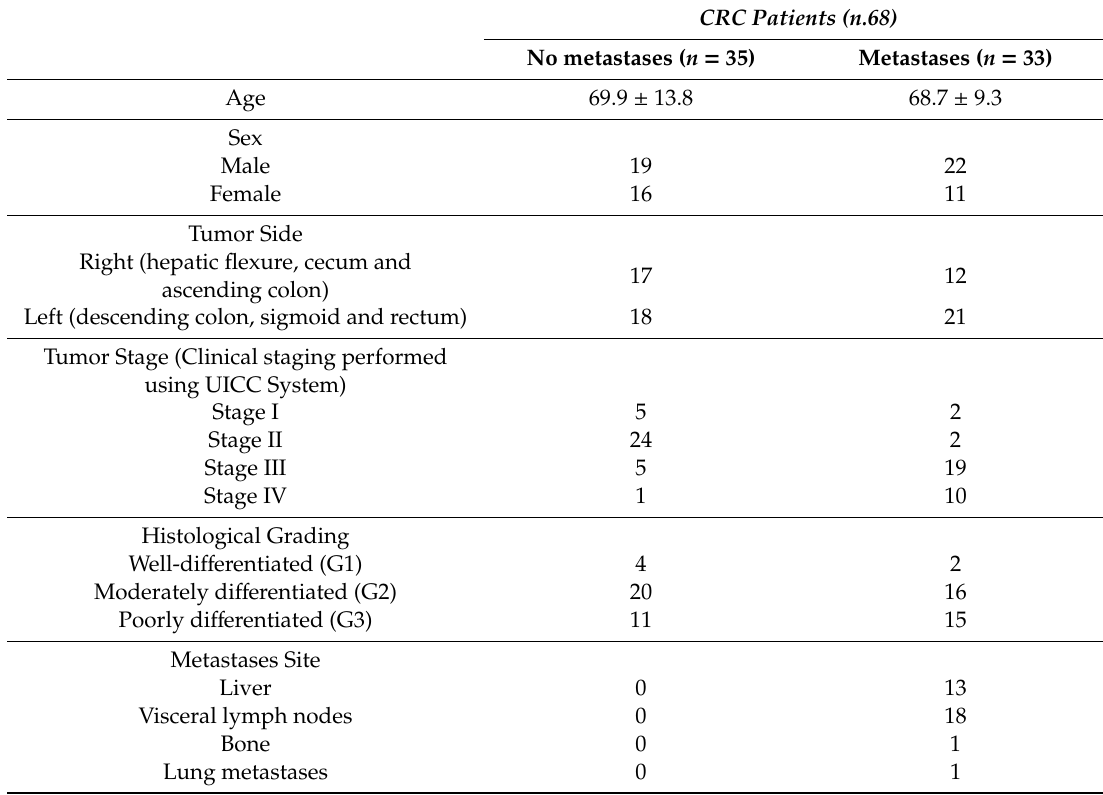
Table 1. Descriptive table of the main clinical and histopathological characteristics of colorectal cancer patients with and without synchronous metastasis.